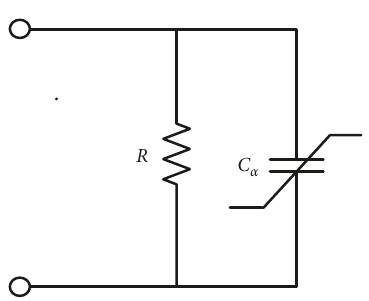
Figure 5: The source-free resistor-fractional capacitor